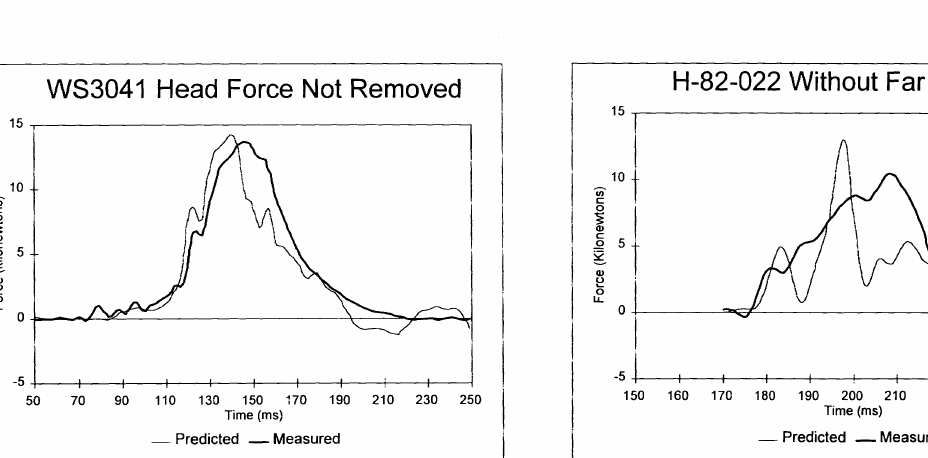
FIGURE 1 Measured and predicted forces without head force removal.